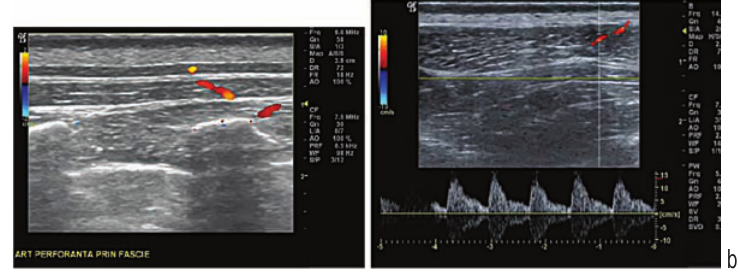
Fig. 2. Perforator vessel identified using Color Doppler ultrasonography